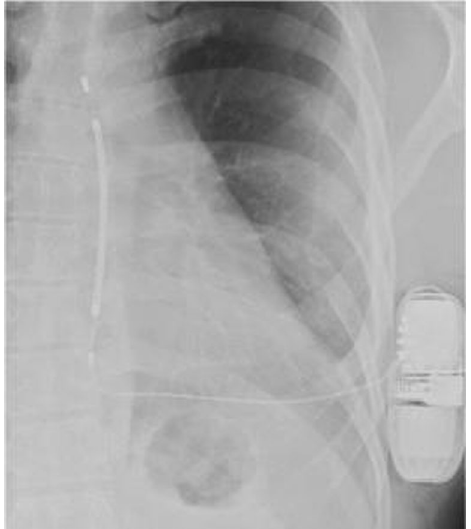
Fig. 12 Chest radiograph demonstrating an AICD in situ. A limited number of AICDs are MR-conditional, such as the Medtronic Evera ™